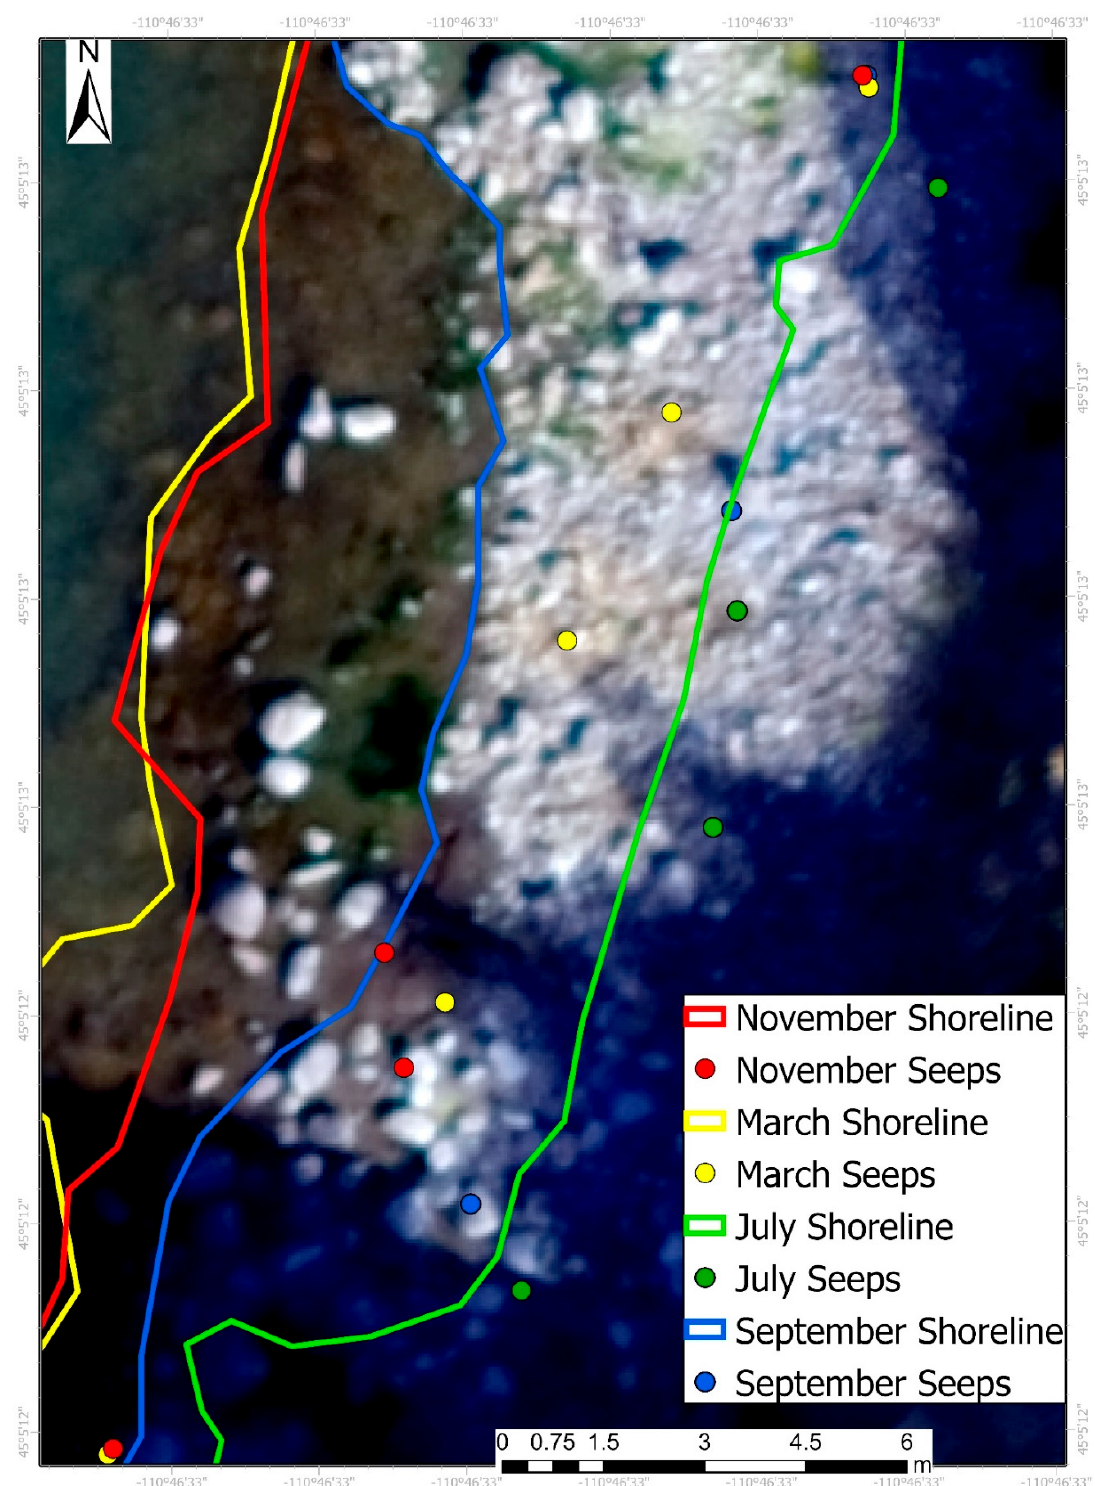
Figure 13. Location of geothermal seeps. The river edge through time is shown as colored lines. The colored dots show corresponding geothermal seep locations through time. The background image is from September 2019 when the discharge was 53.5 m 3 /s.